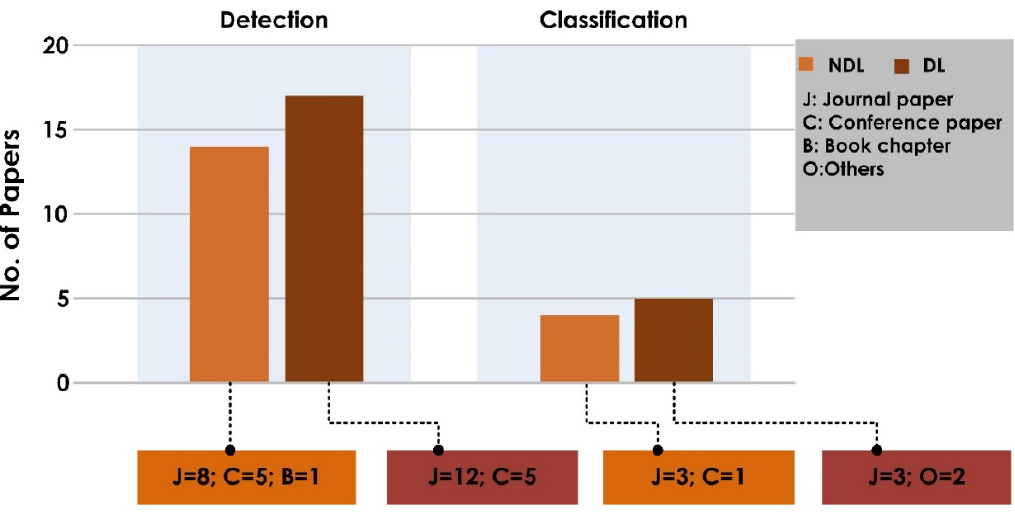
Figure 8. Distribution of the articles from 2010 to 2021.